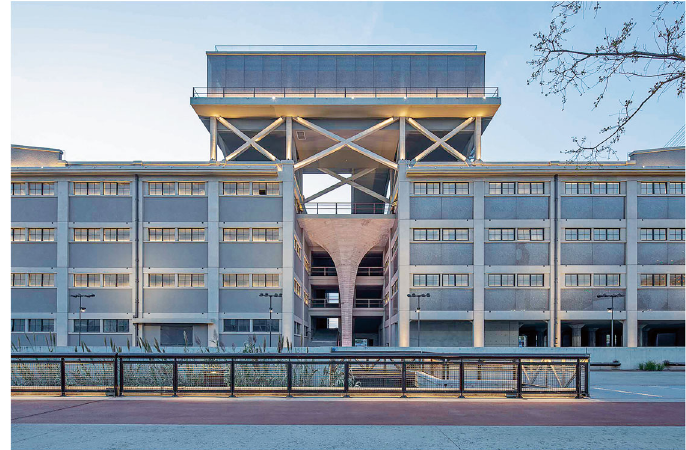
Fig. 13 Symbiotic Twin Façades: the old and the new (Source: Fangfang Tian)